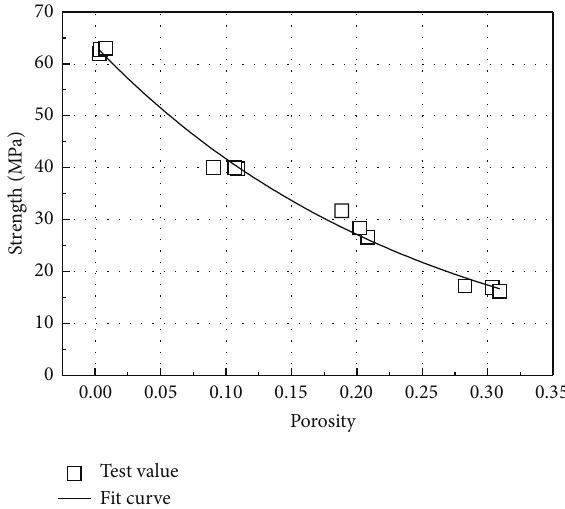
Figure 5: The variation of compressive strength of EPS particles replacing concrete with porosity.